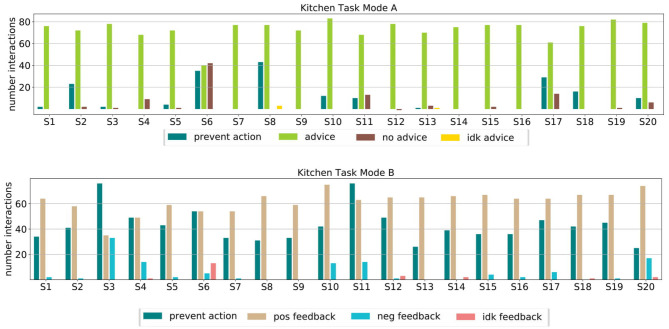
We evaluated how the subject interacted with the robot in Mode A and Mode B. The top row shows the interactions for Mode A split into the different input forms, namely preventing actions, actively suggesting actions (advice) not giving input (no advice) and the “I don't know” option (Idk advice). Most subjects actively gave advice. Notable is the behavior of subject 6, who let the robot explore a lot on its own, which resulted also in slower learning. The bottom row shows the interactions for Mode B split into the different input forms, namely preventing actions, giving positive, negative, or “I don't know” feedback. It shows that most subjects rather prevented actions than gave negative feedback. Notable is subject 3, which prevented many actions and gave a lot of negative feedback resulting in worse learning.